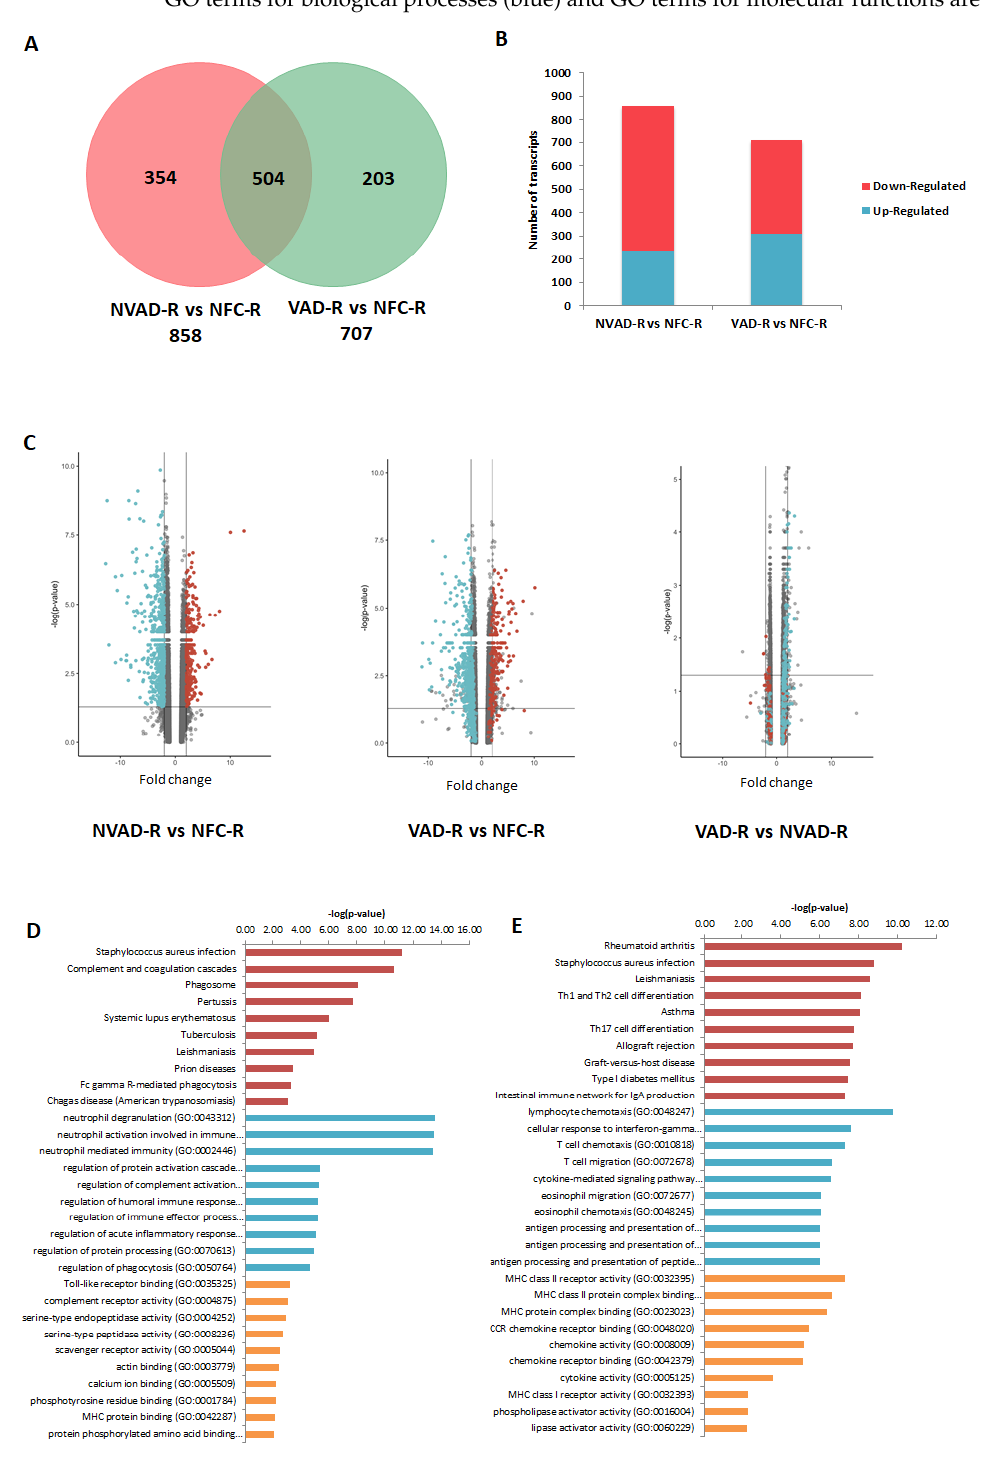
following LVAD use. The top ten Kyoto Encyclopedia of Genes and Genomes (KEGG) pathways (red), GO terms for biological processes (blue) and GO terms for molecular functions are shown (yellow).